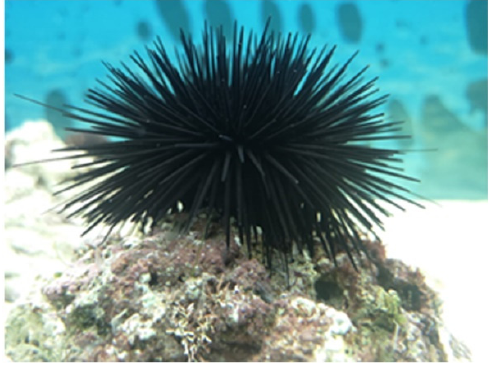
Figure 1. A specimen of Arbacia lixula sea urchin .